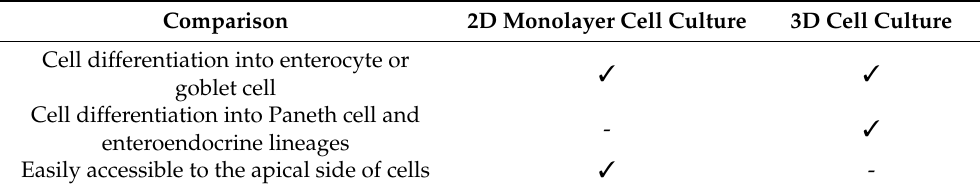
Table 1. Comparison of 2D versus 3D cell cultures (as reviewed in [28–30]). The phrase 2D cell culture refers to monolayer epithelial cells (not derived from organoid/enteroid models), whereas 3D cell culture refers to organoid and enteroid models.